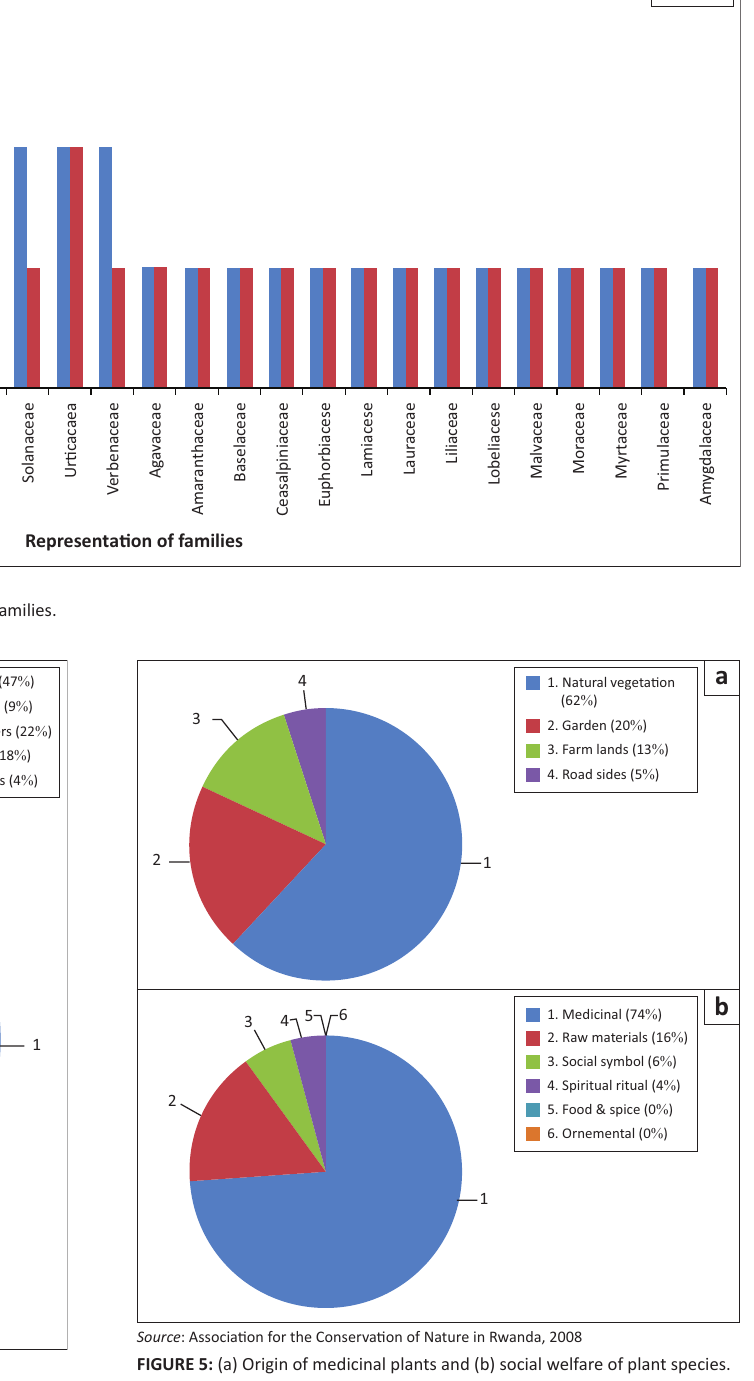
FIGURE 4: Life form proportion of plant species.